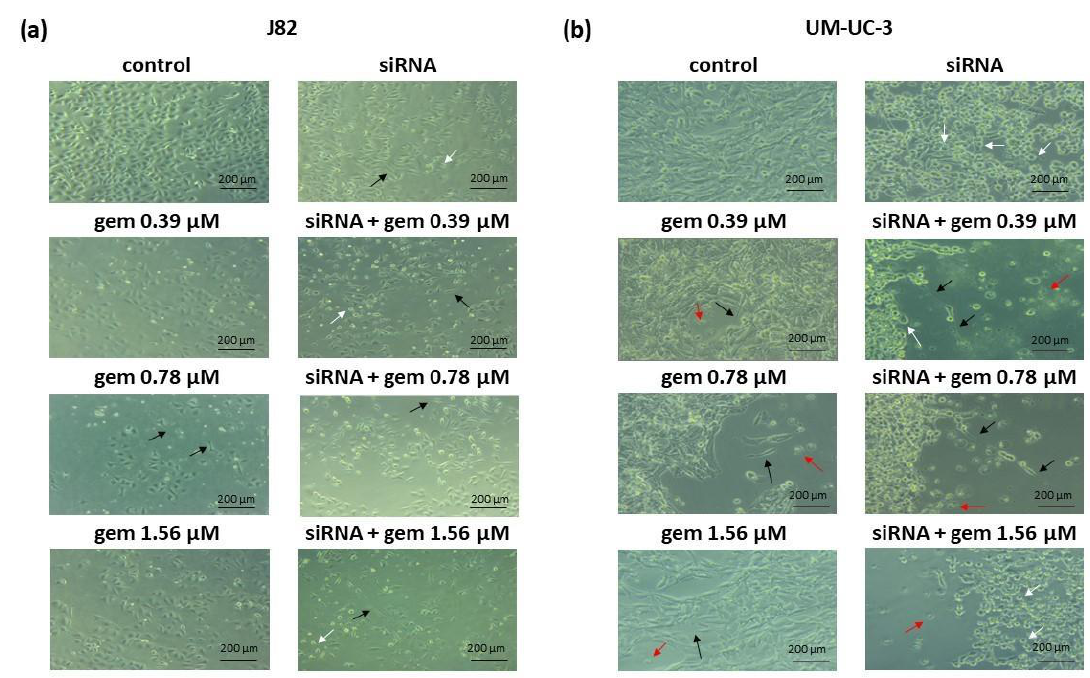
Figure 3. Morphologies of J82 (a) and UM-UC-3 ( b ) cells after treatment with gemcitabine, siRNA- JHDM1D-AS1, or gemcitabine combined with siRNA- JHDM1D-AS1 . Control: untreated cells; gem: gemcitabine. Black arrows: elongated cells; white arrows: round cells; red arrows: dead cells. Phase-contrast microscope, ×200.